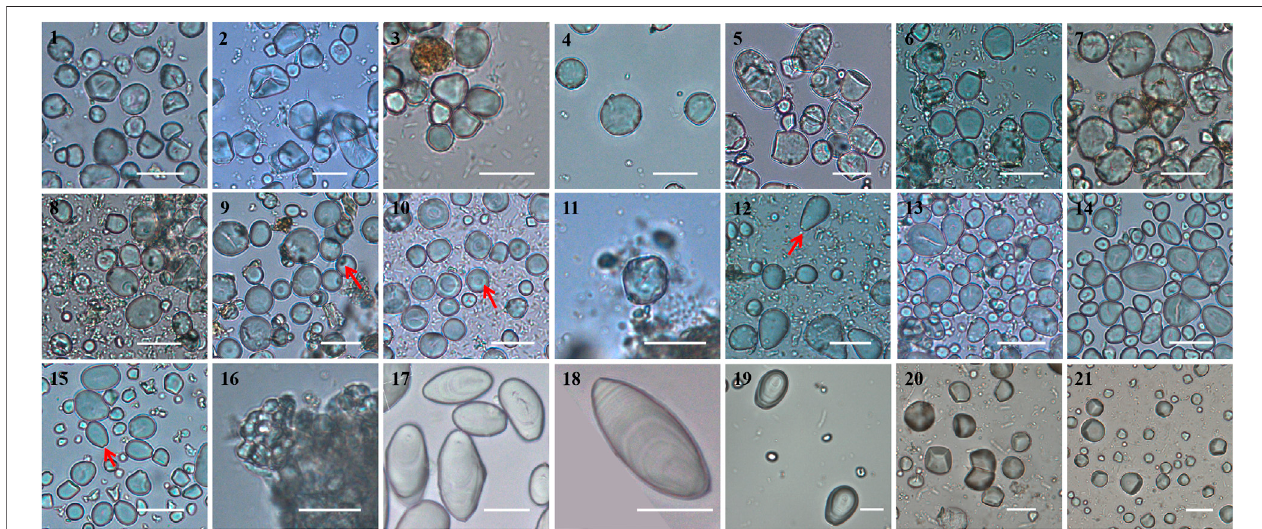
FIGURE 2 | Starch granules from woody starch plants. 1 – 16, acorn kernels:1, Castanopsis platyacantha ; 2, Castanopsis hystrix ; 3, Castanopsis fargesii ; 4, Castanopsis sclerophylla ; 5, Cyclobalanopsis glauca ; 6, Cyclobalanopsis chapensis ; 7, Cyclobalanopsis gambleana ; 8, Cyclobalanopsis phanera ; 9, Lithocarpus cleistocarpus ; 10, Lithocarpus litseifolius ; 11, Lithocarpus chrysocomus ; 12, Quercus cocciferoides ; 13, Quercus oxyphylla ; 14, Quercus variabilis ; 15, Quercus franchetii ; 16, Fagus sylvatica ; 17 – 18, guanglang palm: 17, Arenga westerhouti (red); 18, Arenga westerhouti (white); 19, fi shtail palm: Caryota obtus a; 20 – 21, cycads: 20, Cycas panzhihuaensis ; 21, Cycas pectinata . Scale, 20 μ m. The red arrows shows the pits in the